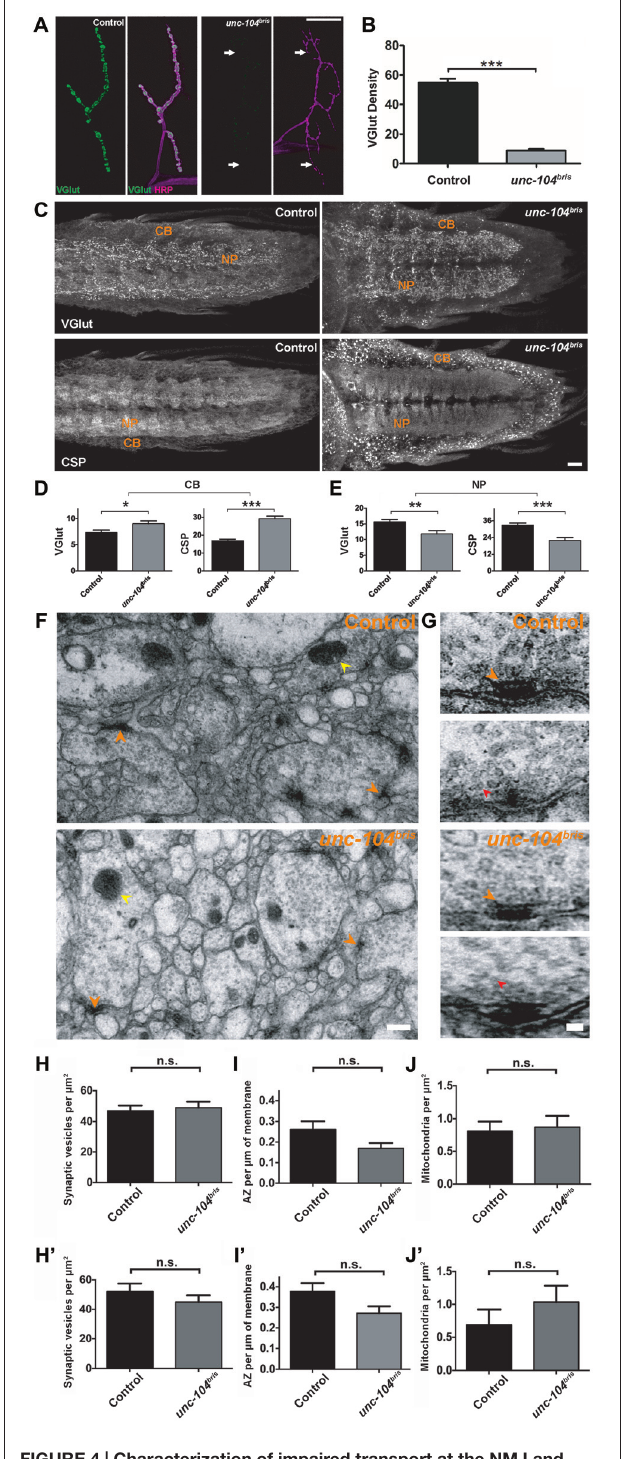
FIGURE 4 | Characterization of impaired transport at the NMJ and ventral nerve cord (VNC) in unc-104 bris mutants. (A) Representative confocal images of NMJs from control and unc-104 bris mutant larvae stained with antibody against vescicular glutamate transporter (VGlut, green in A ). Neuronal membranes were visualized using horseradish peroxidase (HRP) staining (magenta in A ). (B) Quantification of VGlut at the NMJs shown in (A) , per HRP area (VGlut density; control: 54.70 ± 2.75 a.u.; unc-104 bris :